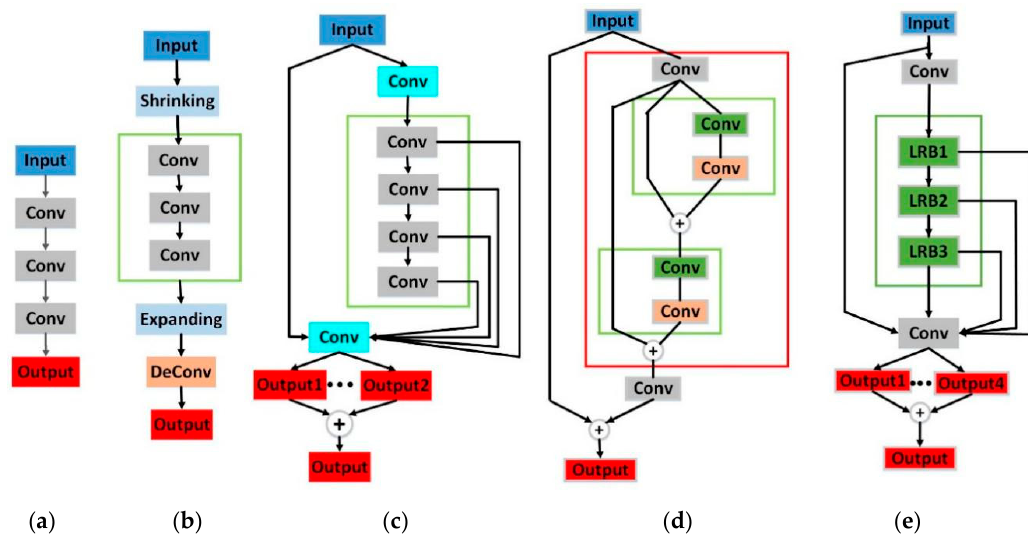
Figure 1. ( a ) Super-Resolution Convolutional Neural Network (SRCNN). ( b ) Accelerating the Super-Resolution Convolutional Neural Network (FSRCNN). ( c ) Deeply-Recursive Convolutional Network for Image Super-Resolution (DRCN). ( d ) Image Super-Resolution via Deep Recursive Residual Network (DRRN). ( e ) Image Super-Resolution Reconstruction Method Based on Global and Local Residual Learning (GLRL).